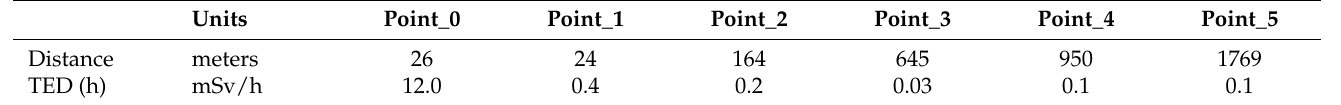
Table 5. Calculation of dose and residence time at various distances from the fire point of a source of Cs-137 with an activity of 1.9 × 10 3 GBq, calculated for its maximum (20 min after ignition). Units